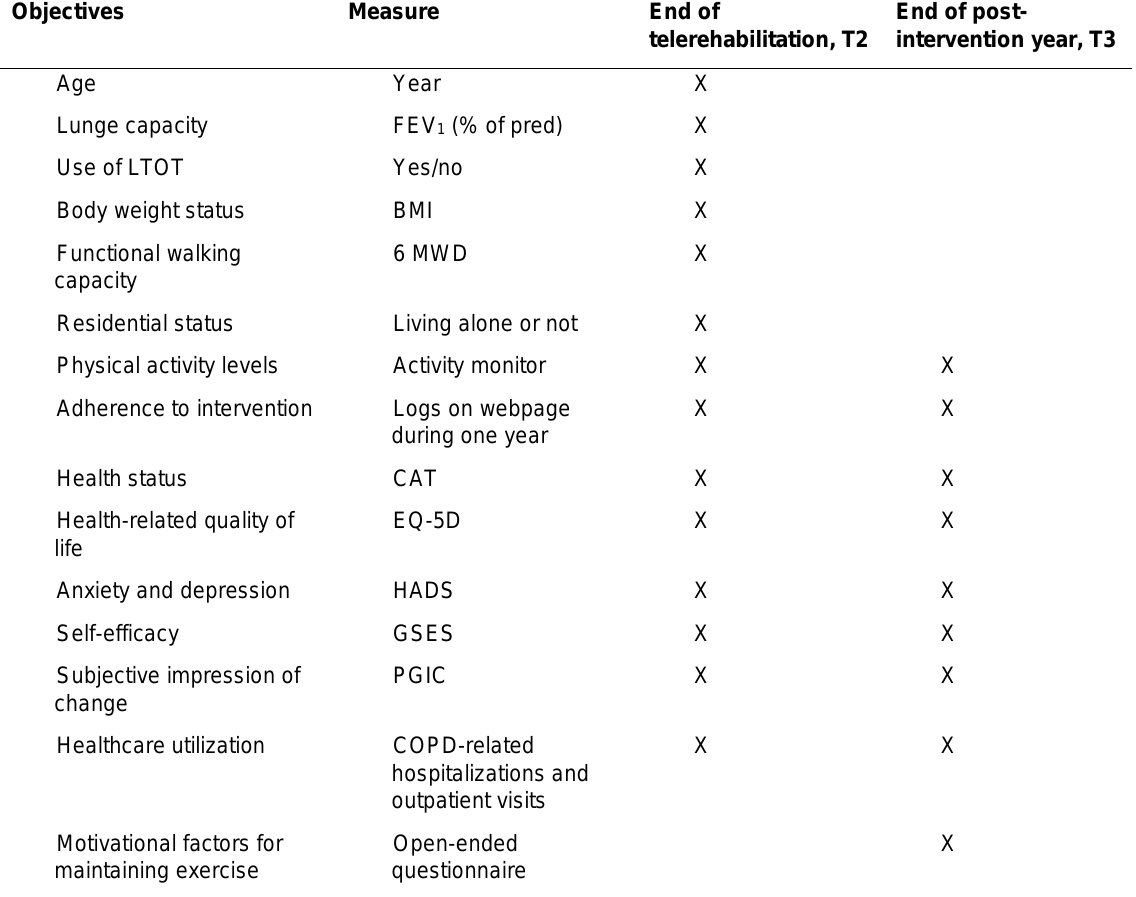
Table 1. Study Objectives and Time Points for Data Collection